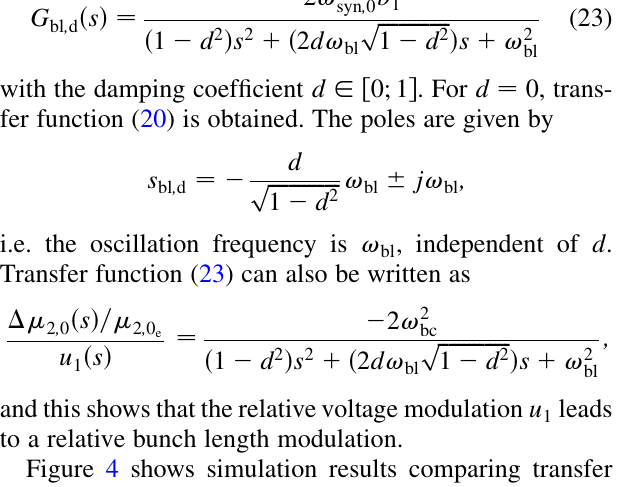
FIG. 4. Simulation: Comparison of a nonlinear tracking simulation (black line) with the linear system (23) with damping d ¼ 0 : 15 (blue line) and equilibrium ~ (cid:7)